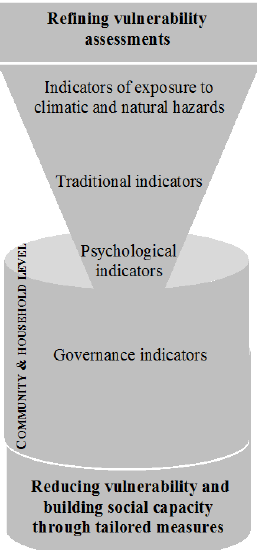
Fig. 1. Concept for integrating psychological and governance fac- Figure 1. Concept for integrating psychological and governance factors